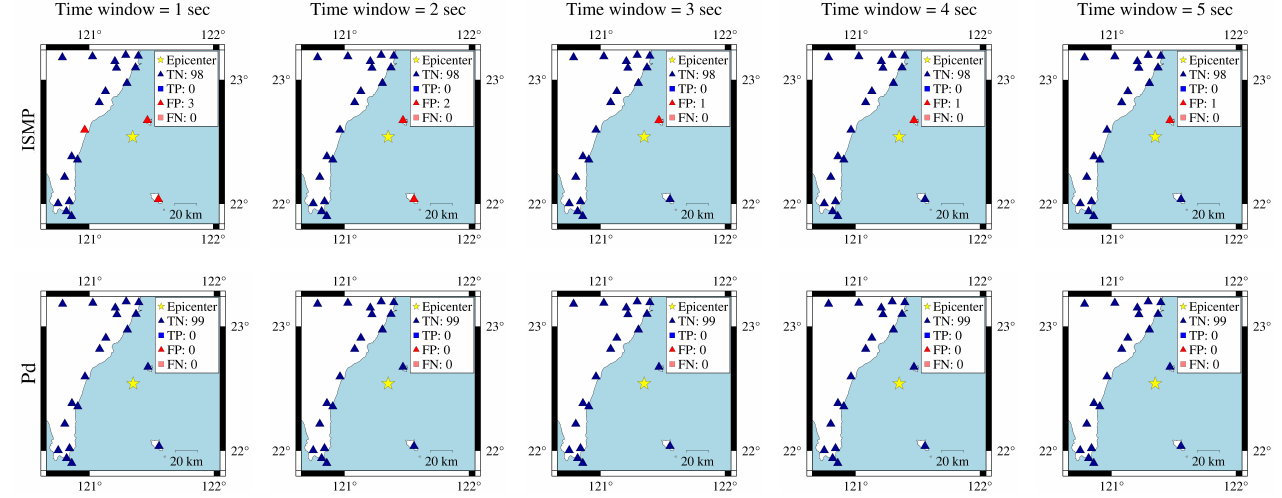
Figure 10. Comparison of ISMP and Pd schemes using different time windows for the 17 January 2021 Taitung event. The first and second rows are the prediction results of the ISMP and Pd schemes, respectively. The yellow star represents the event epicenter. The triangles are the stations with actual PGA < 80 Gal and the squares are the stations with actual PGA ≥ 80 Gal, where the blue and red colors represent stations that make correct and false predictions,